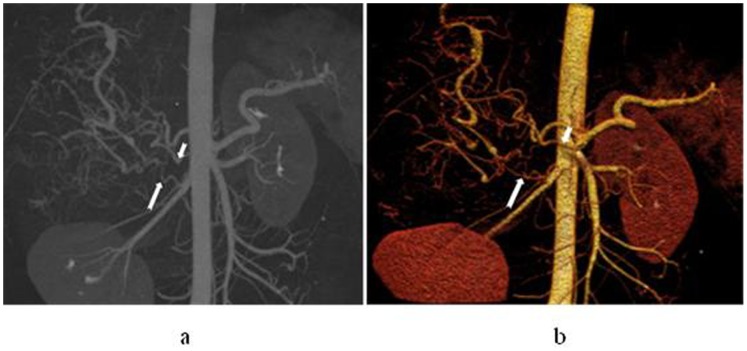
In a 35-year-old man with hepatocellular carcinoma in S6 and S7, right renal artery and adrenal artery participate in blood supply for the carcinoma.Maximum intensity projection (a) and volume rendering technique (b) display that right adrenal artery (short arrow) and the initial segment of right renal artery (long arrow) gives off branches into the tumor.